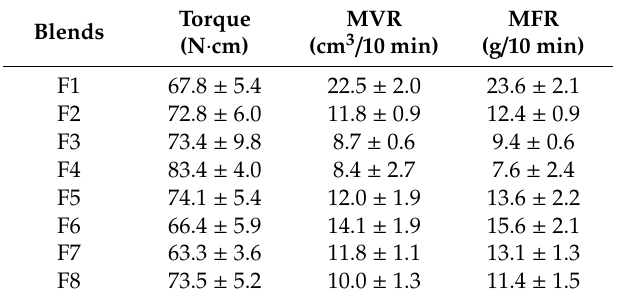
Table 7. Torque, MVR, and MFR values of the prepared blends.